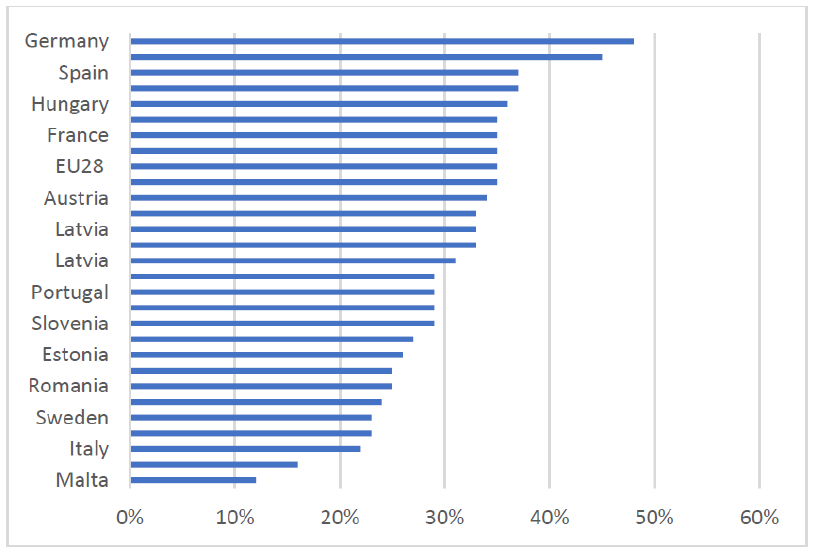
Figure 4. Citizens choosing alternatives to buying new products. Source: Own representation based on Eurostat data [33] .